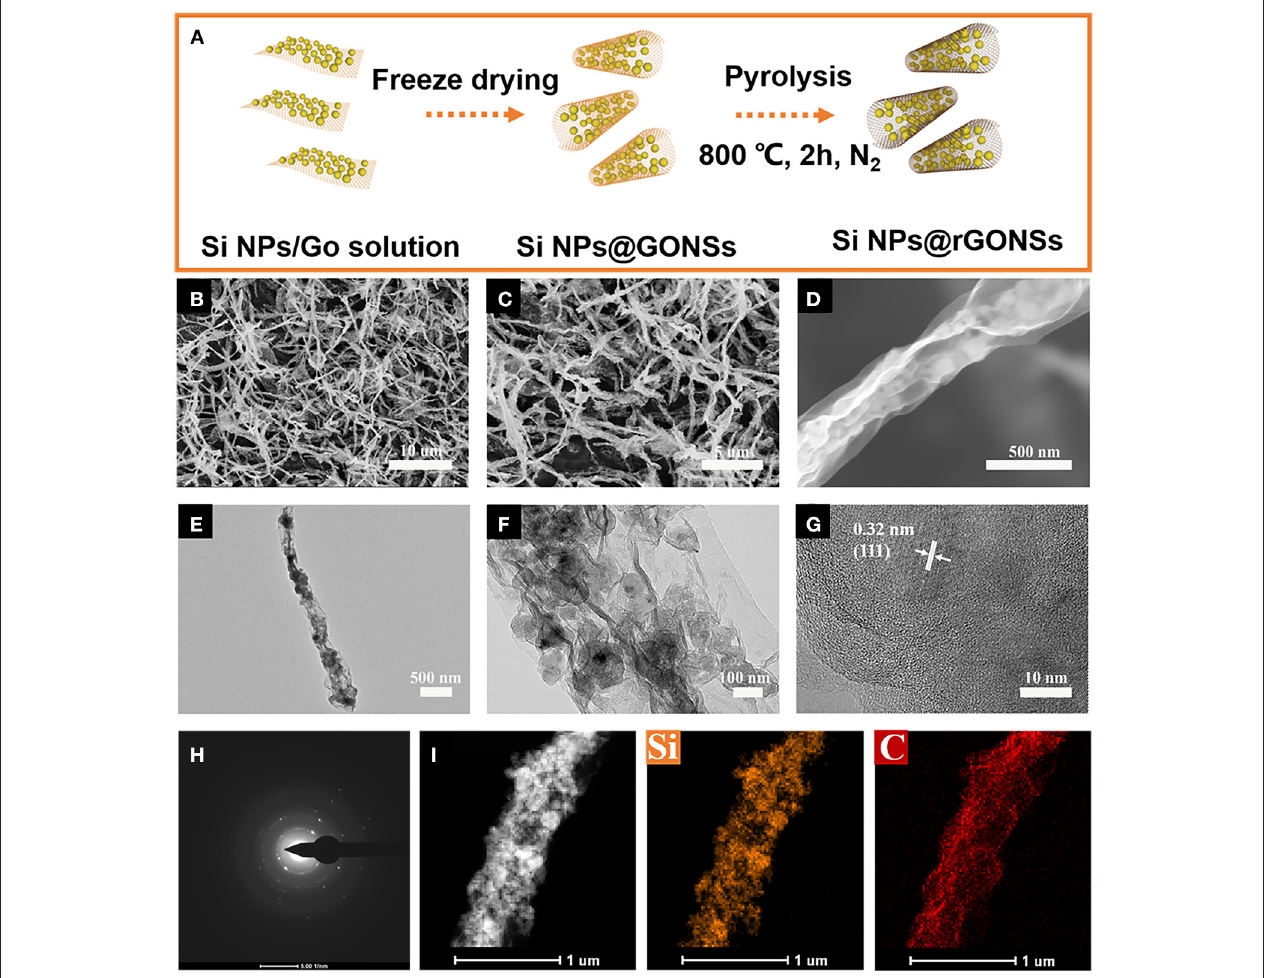
FIGURE 1 | (A) Schematic fabrication process of Si@rGONSs-2, (B,C,D) SEM images, (E,F) TEM images, (G) HRTEM image, (H) SAED image, and (I) elemental mapping results of Si@rGONSs-2.